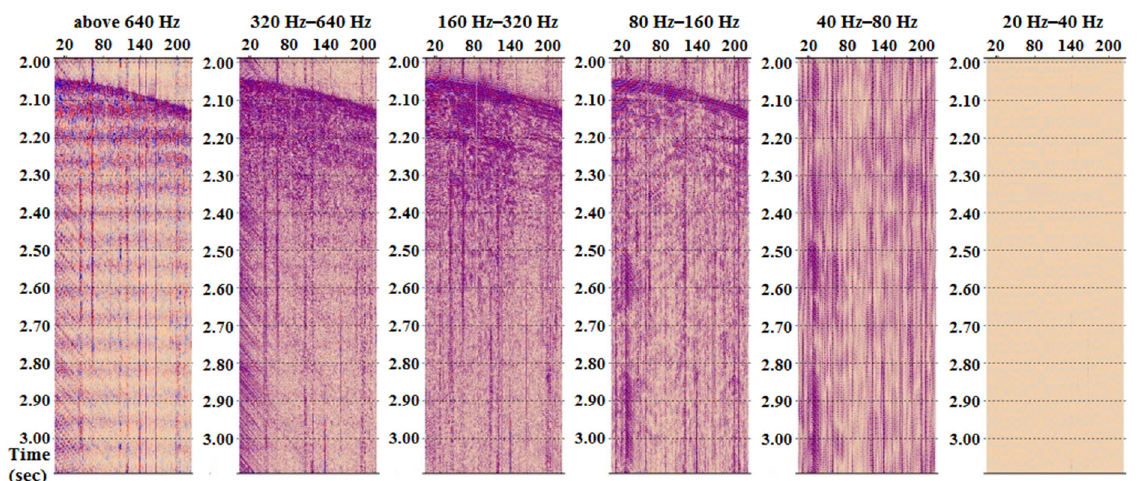
Figure 9. Reflection profile in deep water and spectrum diagram of shallow strata. 4. Results After years of accumulative technical improvements, a high ‐ precision 3D seismic detection system for gas hydrate was successfully developed, which includes a 50 kJ ul ‐ trahigh ‐ energy plasma source, two high ‐ resolution digital seismic streamers with a